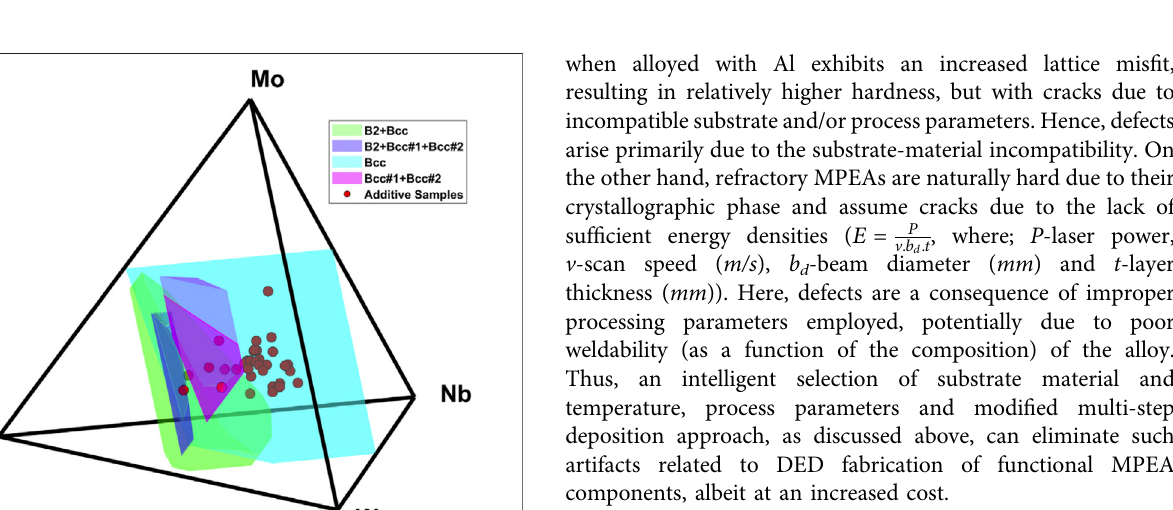
FIGURE8| LMDofMoNbTaW refractoryMPEA. (A) RepresentationoftheinitialdepositiontrackoftheMPEA.Unmelted powderparticlescanbeseenallover the track due to lack of suf fi cient power during deposition. (B) Remelted track of the MPEA. A clear, mixed and a homogenous track can be seen after remelting the initially deposited track. Remelting was done with signi fi cantly higher power that can suitably melt most of the particles (Dobbelstein et al., 2016).